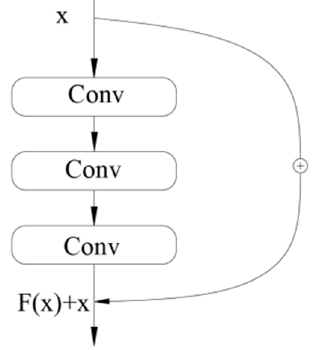
Figure 12. ResNet